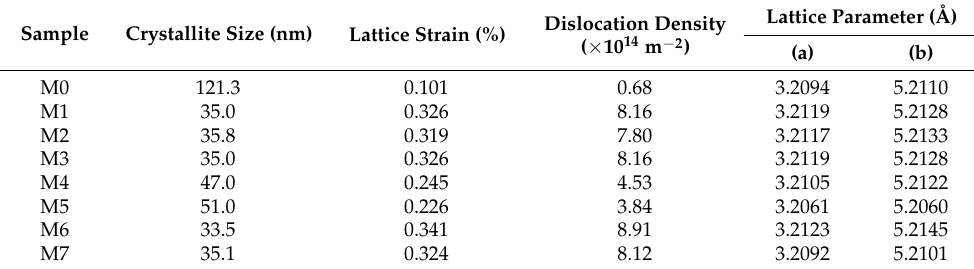
Figure 5. XRD patterns of pure Mg powders after high-energy ball milling processes according to the conditions of Table 1. Table 2. Crystal structure data for pure Mg under different milling conditions.